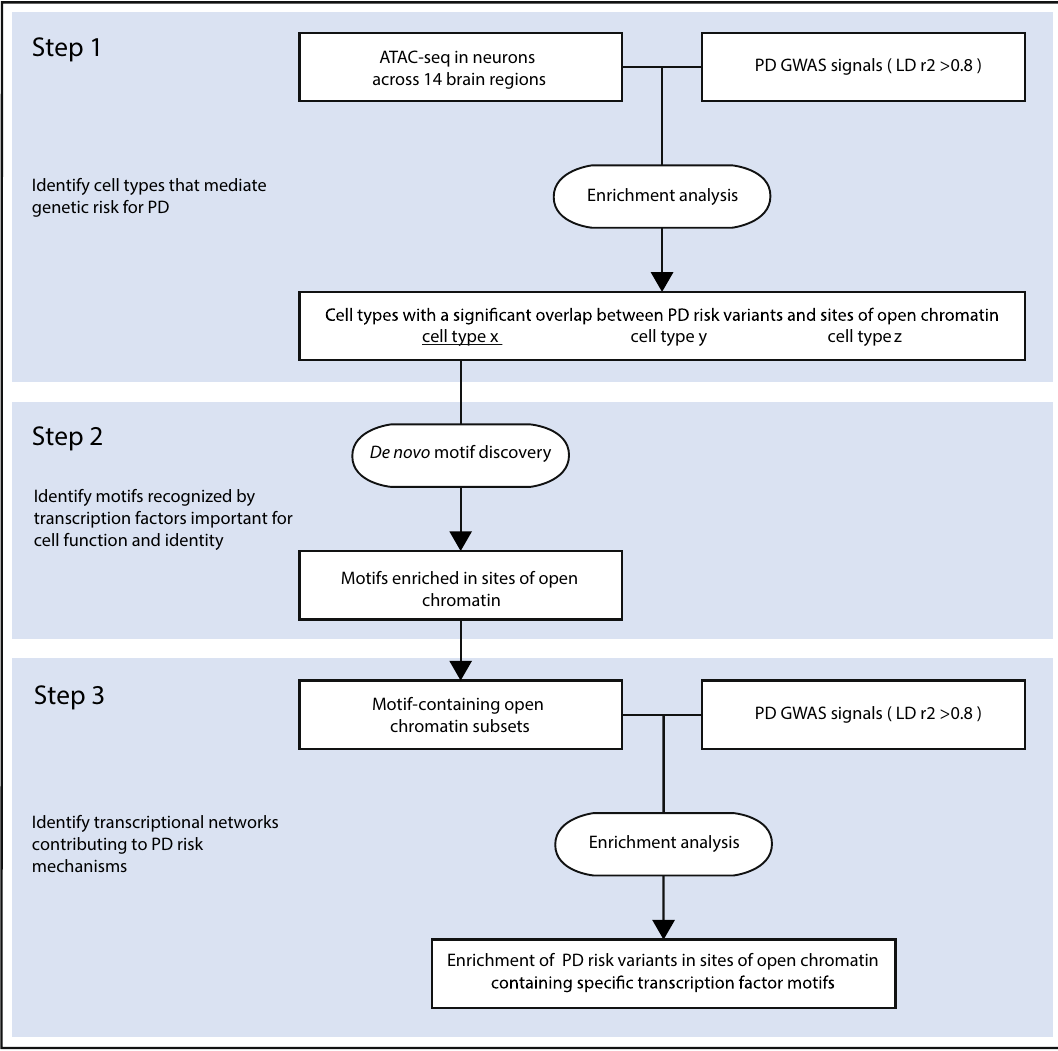
Figure 1. Workflow of the data analysis. PD, Parkinson’s disease; GWAS, Genome-wide association study; LD, Linkage